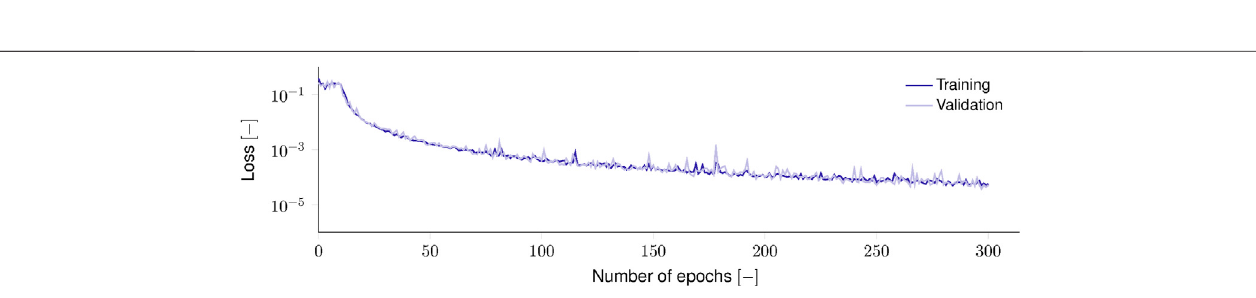
FIGURE 9 | Training and validation loss during elastoplastic constitutive model